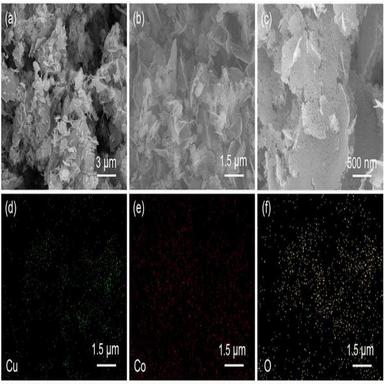
(a–c) SEM images of CuCo2O4/CuO nanosheets with their elemental mappings of (d) Cu, (e) Co, and (f) O, respectively. The mapping images were taken from the same position in (b).